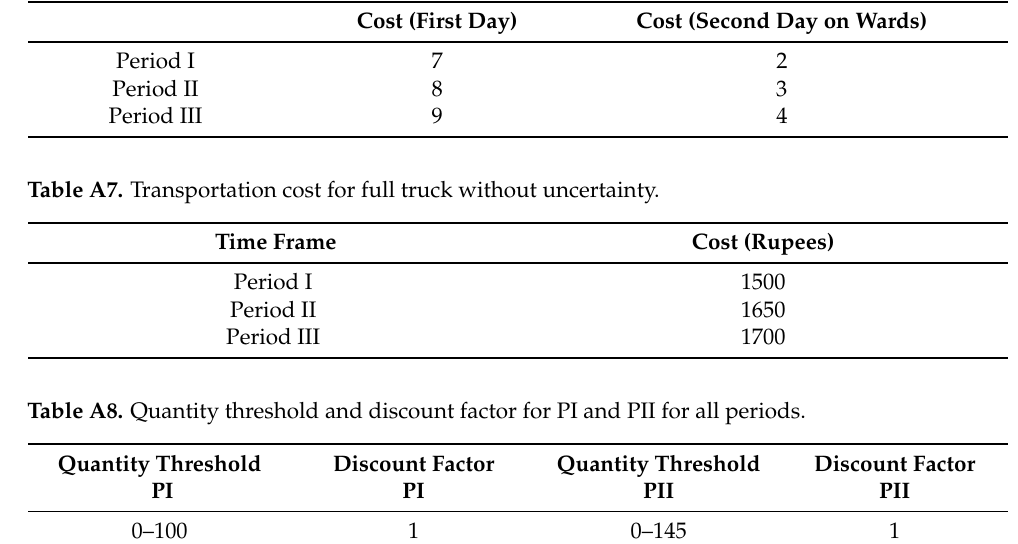
Table A6. Holding and Halting Cost per 100 kg weight in road.